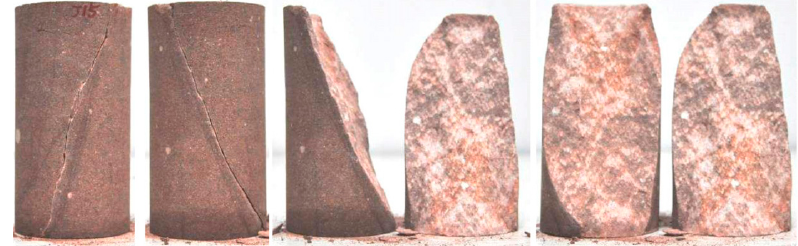
Figure 2. A typical macro contact of granular material [17].